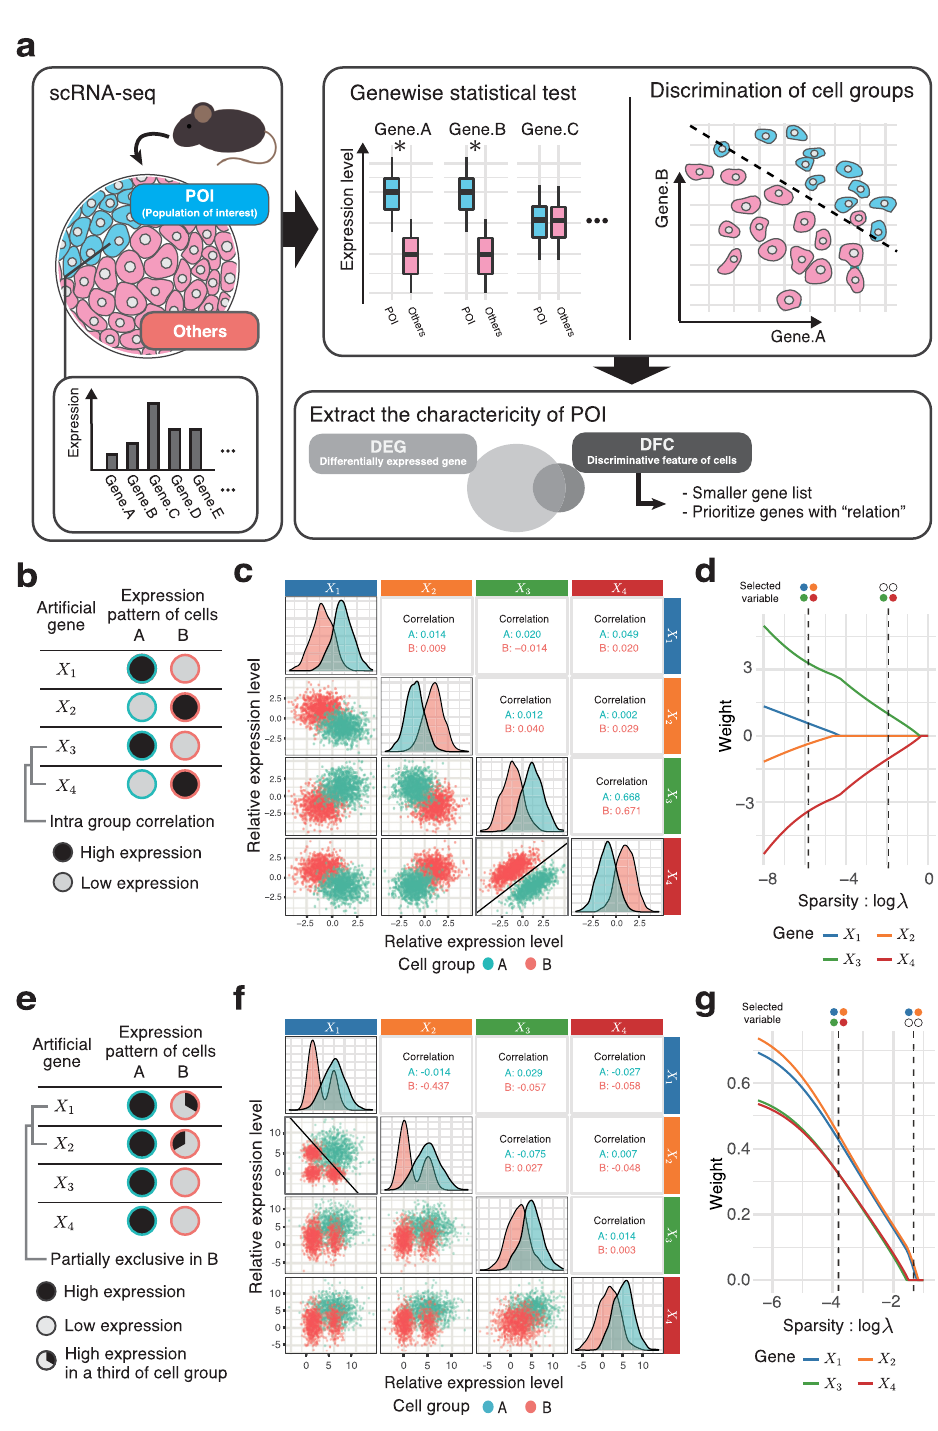
Fig 1. The dependent pairs of gene expression selected as the DFC. (a) Different concepts for gene selection of DFC and DEG. The common goal is to extract a set of genes that characterizes the population of interest (left). A DEG- based approach involves a list of genes with statistically significant differences between the studied groups. In contrast, the DFC-based approach involves a subset of genes that distinguish between two populations (top-right). DFC is expected to feature a small set of genes selected by taking into account the relationships among genes (bottom-right). (b–d) Artificially generated data set in which DFC has priority over DEG; case 1: correlation. (b) Schematic of the synthesized data design. Only the pair X 3 and X 4 has intra-group correlation; the other pairs are independent.